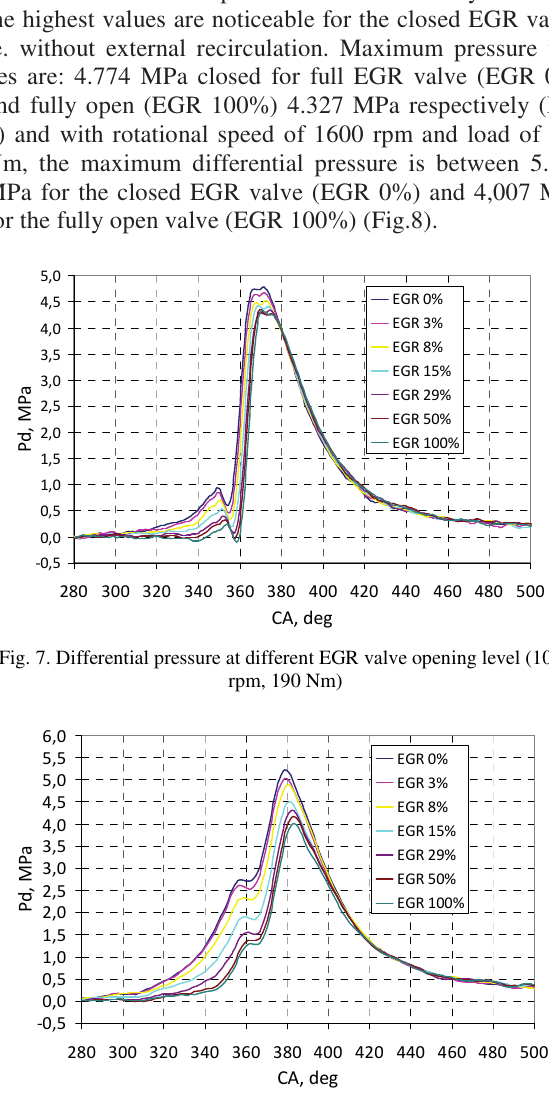
Fig. 8. Differential pressure at different EGR valve opening level (1600 rpm, 190 Nm)